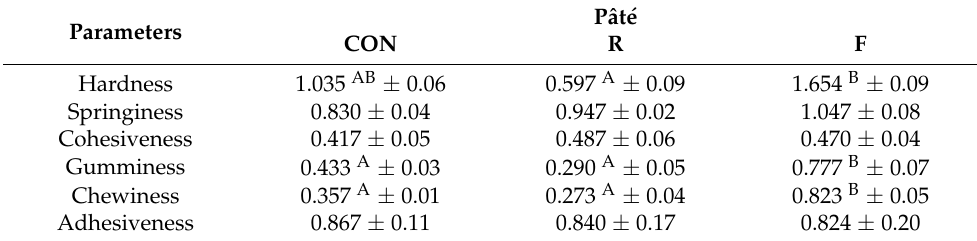
Table 4. Texture parameters of pork p â t é s (mean ± s.d.).